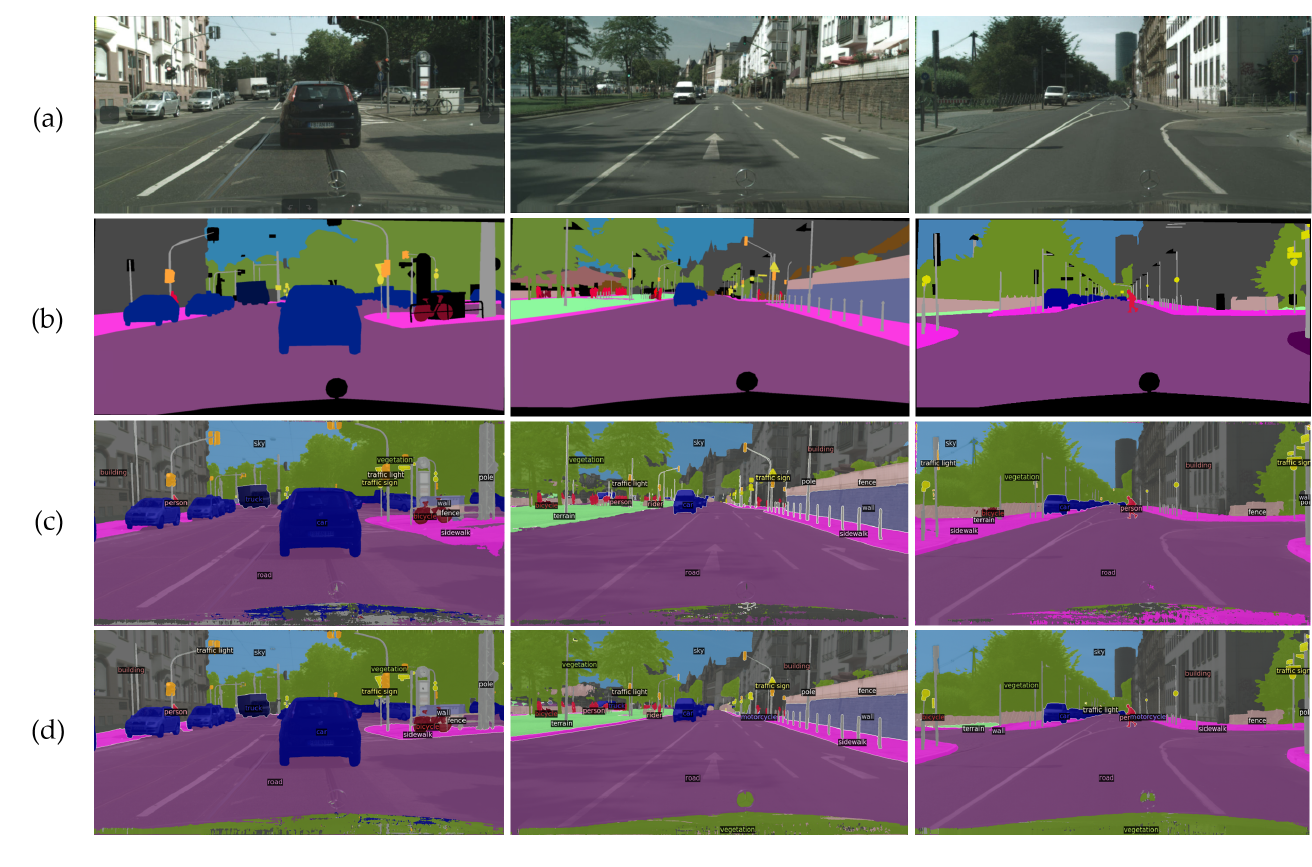
Figure 3. Semantic segmentation results based on the Cityscapes validation dataset. ( a ) RGB input, ( b ) ground truth, ( c ) baseline method, and ( d ) our proposed method. The proposed method using the auxiliary CNN improves the detection of local information and small objects compared with the baseline method